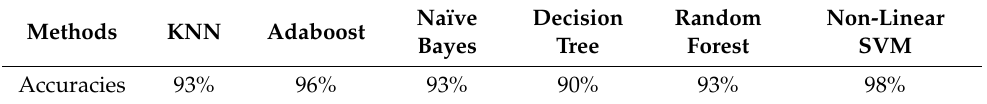
Table 7. All classifier accuracies.